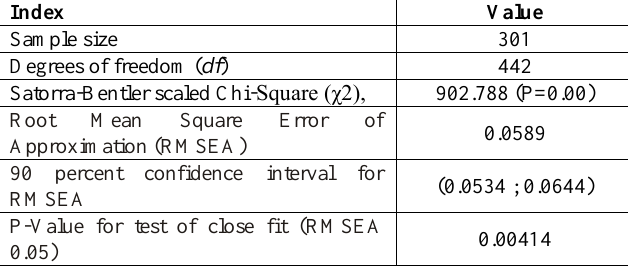
Table 5: Goodness-of-fit indices for the structural